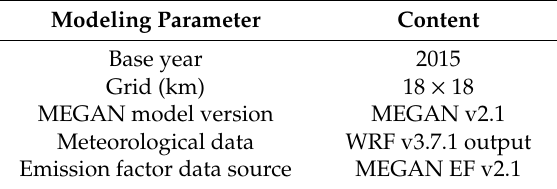
Figure 1. Definition of emissions modeling domain. Table 1. Modeling parameter information.